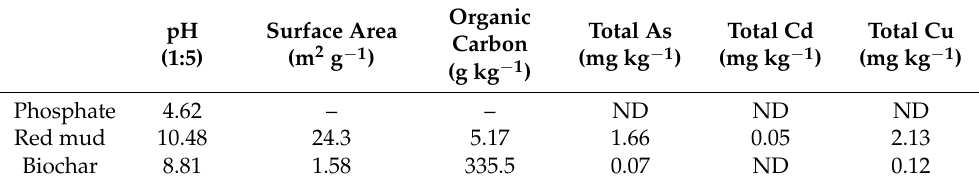
Table 1. The physical and chemical properties of the three